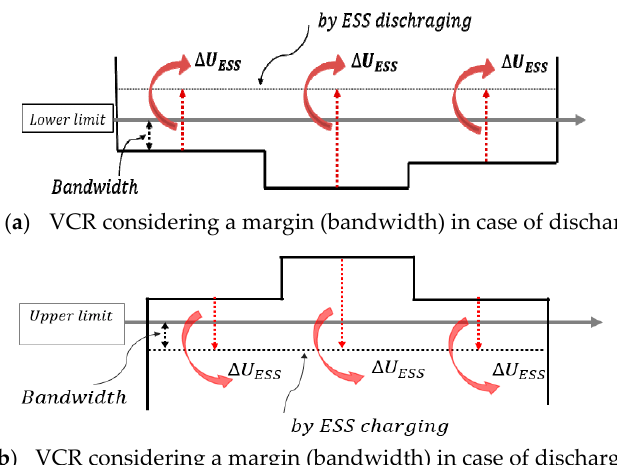
Figure 6. Concept of the voltage compensation rate (VCR) considering a margin (bandwidth).